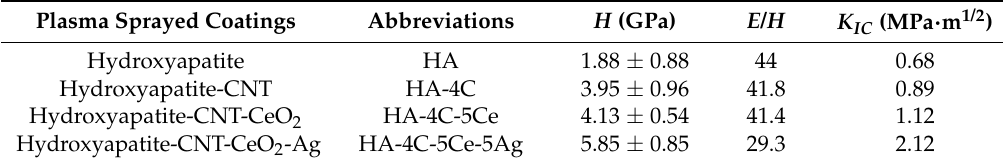
Table 1. Abbreviations used and the mechanical properties ( H , E , and K IC ) of the coatings. Plasma Sprayed Coatings